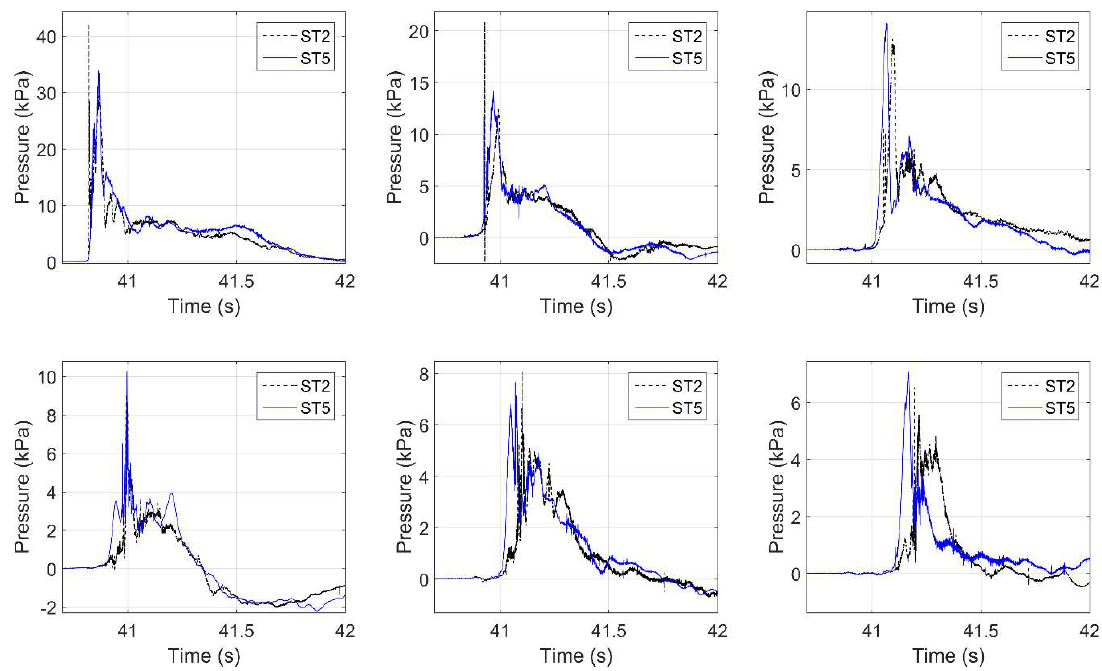
Figure 7. Applied wave pressures on the offshore side of girders ( top ) G1 ( left ), G2 ( middle ), and G3 ( right ); and below the deck ( bottom ) in chambers Ch1 ( left ), Ch2 ( middle ), and Ch3 ( right ) for a bore with H = 0.42 m and two deck types